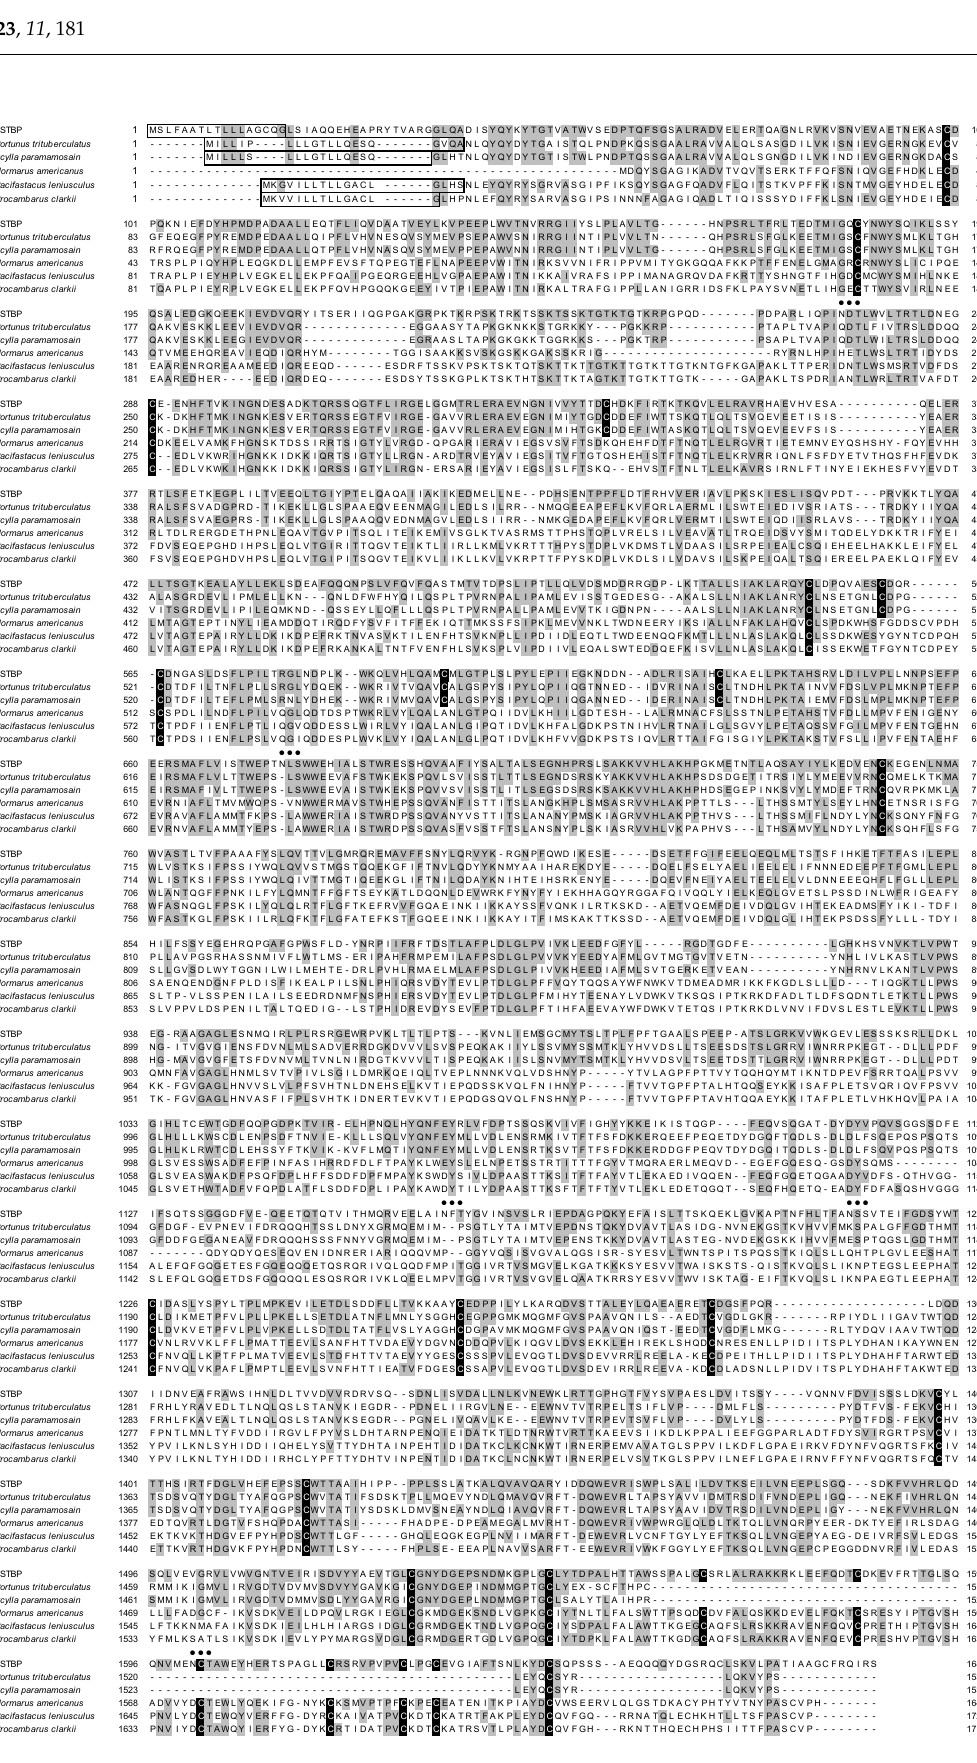
Figure 4. Deduced amino acid sequence alignment of TTX binding protein, HSTBP, with clotting proteins of shrimp and crab from the suborder Pleocyemata. Accession numbers for clotting